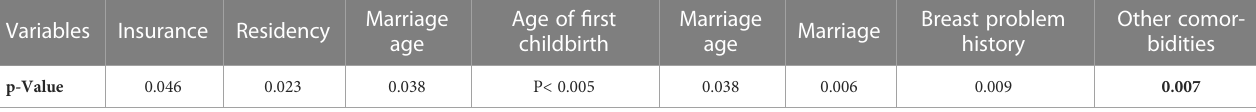
TABLE 3 Outcome of chi-square method of selected variables.